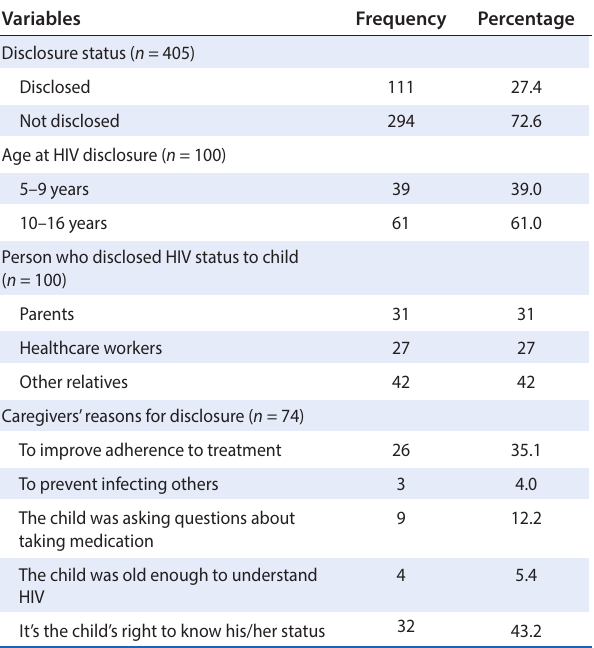
Table 3: Disclosure status of children and caregiver reasons for disclosure